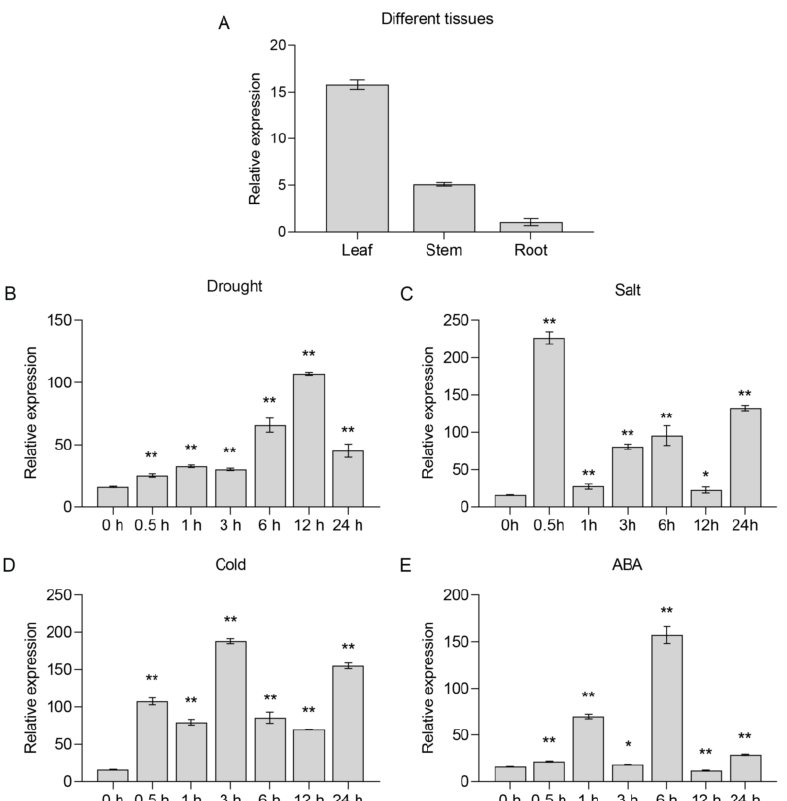
Figure 2. Expression patterns of SlNAC10 in S. liaotungensis under normal conditions. ( A ) Expression patterns of SlNAC10 in roots, leaves, and stems under normal conditions. Expression patterns of SlNAC10 in seedling leaves in response to ( B ) salt treatment; ( C ) drought treatment; ( D ) cold treatment; ( E ) ABA treatment. The 2 −ΔΔ CT method was used to measure relative expression levels of the target gene. Each bar represents the mean ± SD of triplicate experiments (* p < 0.05 ; ** p < 0.01).